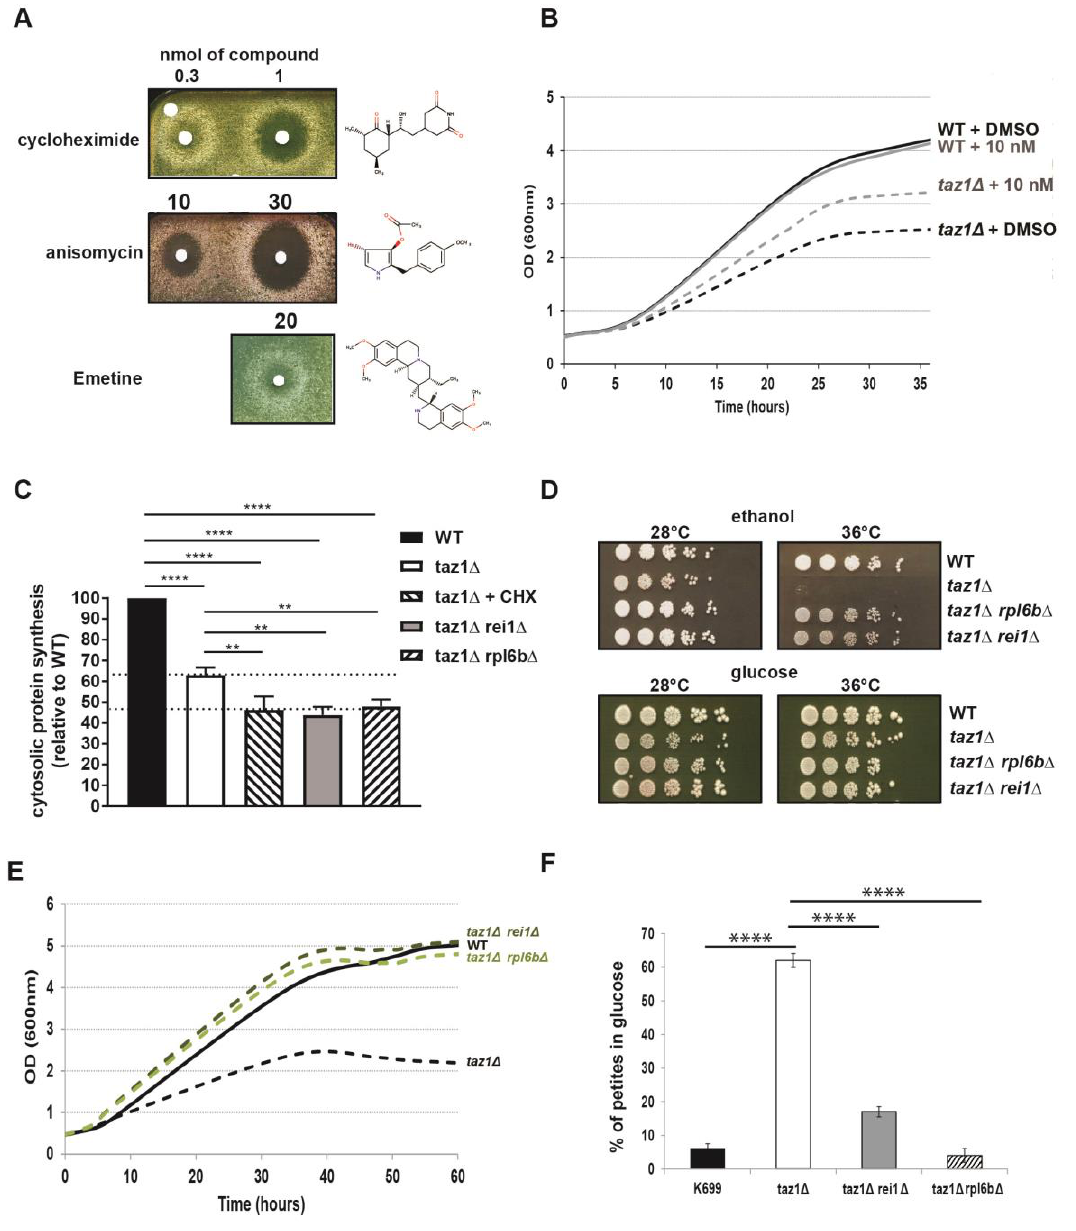
FIGURE 1: Partially decreasing cytosolic translation in Taffazin-deficient ( taz1 Δ) yeast improves respiration-dependent growth and mtDNA maintenance . ( A) taz1 Δ yeast cells were spread as dense layers onto rich ethanol solid media and then exposed to sterile filters spotted with cycloheximide, anisomycin or eme- tine (dissolved in DMSO). The plates were scanned after 5 days of incubation at 36°C. The filter at the top left was spotted with DMSO alone to provide a nega- tive control. (B) Determination in liquid cultures of CHX concentrations that optimally rescue taz1 Δ yeast. Complete synthetic media (CSM) containing 0.5% galactose + 2% ethanol supplemented or not with CHX at the indicated concentrations were inoculated with WT and taz1 Δ cells pre-grown in CSM containing 2% glucose at 28°C. The cultures were performed at 36°C and cells densities (OD 600nm ) taken over a period of 36 hours. (C) Rate of cytosolic protein synthesis. Total proteins and mitochondrial proteins were labeled with a mixture of [ 35 S]-methionine and [ 35 S]-cysteine for 20 min in whole cells from wild type, taz1 Δ rei1 Δ , taz1Δ rpl6bΔ and taz1 Δ yeast grown for 24 hours in rich 0.5% galactose + 2% ethanol at 36°C, and taz1 Δ cells grown in the same conditions in presence of 10 nM cycloheximide (CHX). After the labeling reactions, total protein extracts were prepared and separated by SDS-PAGE on a 12% polyacrylamide gel (75 µg per lane). The gels were dried and analyzed with a PhosphorImager. Quantification was performed using Image J. Data are expressed in % relative to the WT (n=3). The shown data are cytosolic protein synthesis rates (total minus mitochondrial protein synthesis rates). Statistical analysis was done with Tukey’s test (*P<0.05; **P<0.01; ***P<0.001; ****P<0.0001). (D) Genetic ablation of REI1 ( rei1Δ ) or RPL6B ( rpl6bΔ ) improves respiratory growth of taz1 Δ yeast. WT, taz1 Δ, taz1 Δ rei1 Δ and taz1Δ rpl6bΔ cells freshly grown at 28°C in rich glucose were serially diluted and spotted onto rich ethanol and glucose plates. The plates were scanned after 4 days of incubation at the indicated temperature. (E) Growth of WT, taz1 Δ, taz1 Δ rei1 Δ and taz1Δ rpl6bΔ strains in liquid complete synthetic media containing 0.5% galactose + 2% ethanol at 36°C. The cultures were inoculated with cells grown in CSM containing 2% glucose at 28°C. The cultures were performed at 36°C and cell densities (OD 600nm ) taken over a period of 60 hours. (F) Genetic ablation of REI1 ( rei1 Δ) or RPL6B ( rpl6b Δ) in taz1 Δ yeast preserves mtDNA maintenance. Proportions of ρ - /ρ 0 cells produced in glucose cultures at 28°C of strains WT, taz1 Δ, taz1 Δ rei Δ, and taz1Δ rpl6bΔ were determined using the procedure described in [60] (n=3). Data are expressed in % relative to the WT and were statistically analyzed using Tukey’s test (*P<0.05; **P<0.01;